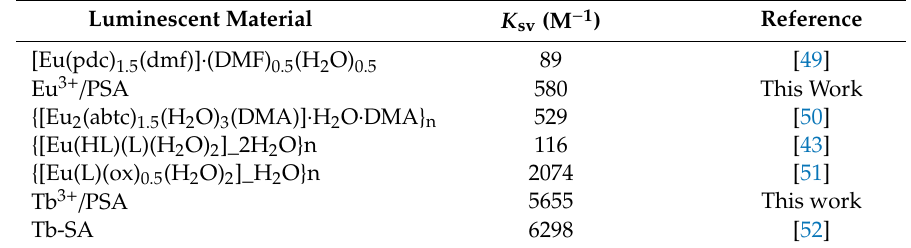
Table 2. Stern-Volmer constant for the quenching of the emission of several lanthanoid-based sensors by Cu 2 +